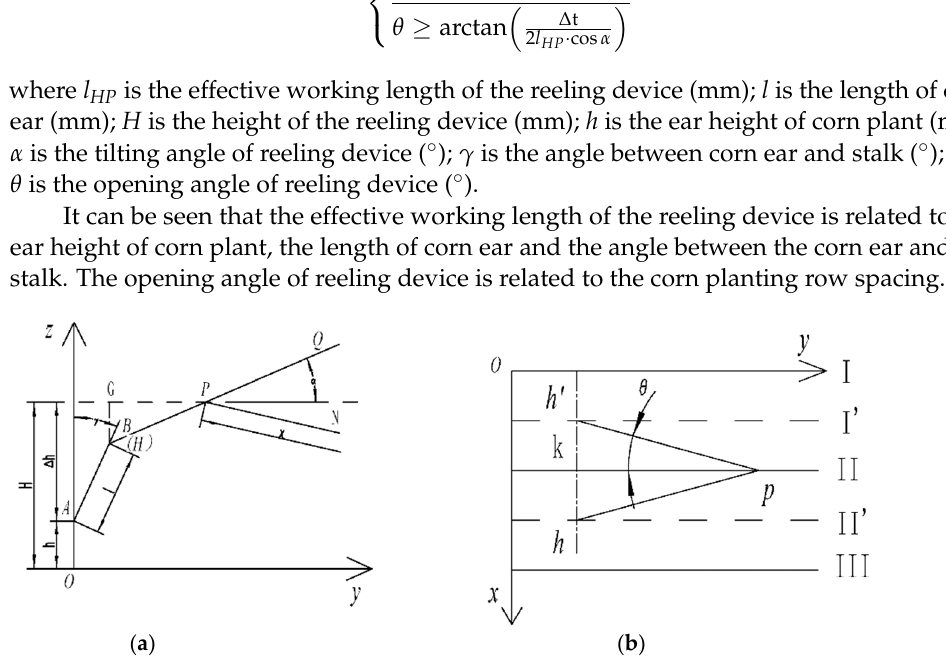
Figure 4. Geometric model of the reeling device. ( a ) the projection in the yoz plane; ( b ) the projection of the reeling device in the xoy plane.